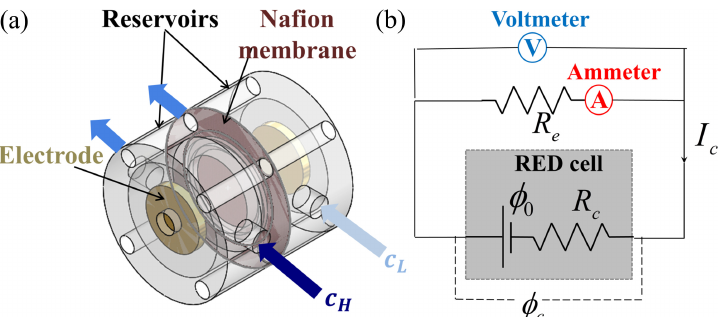
Figure 1. ( a ) Schematic diagram and ( b ) the equivalent electrical circuit of the reverse electrodialysis (RED) cell, comprised of two reservoirs separated by a cation-selective Nafion membrane. Solutions of different salt concentrations ( c H and c L ) flow through the reservoirs. When connecting an external circuit to the two side-electrodes, we obtain the open-circuit voltage ( φ 0 ) and internal resistance ( R c ) of the RED cell under a constant flow rate, by measuring the operating voltage ( φ c ) and current ( I c ) with a voltmeter and ammeter, respectively, while varying the external resistance ( R e )